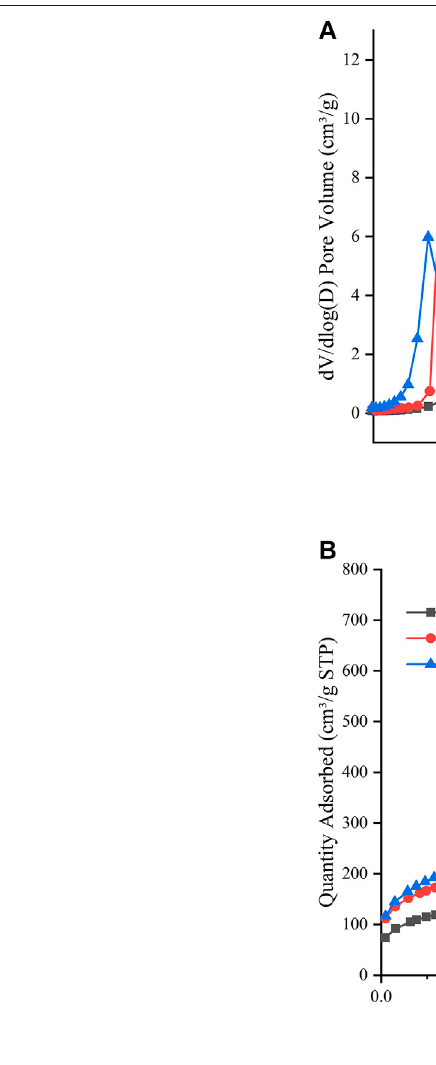
Frontiers in Bioengineering and Biotechnology |